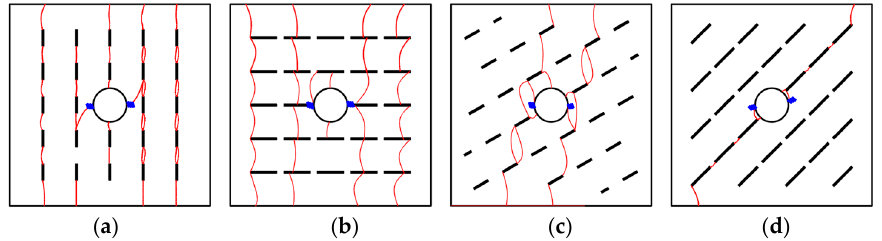
Figure 12. Failure modes of the jointed specimens with a hole. ( a ) Mode I — Axial cleavage; ( b ) Mode II — crushing; ( c ) Mode III — stepped; ( d ) Mode IV — sliding.